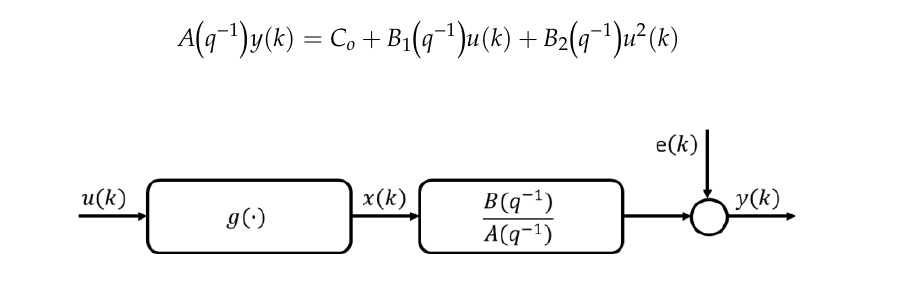
Figure 3. Block diagram representation of SISO Hammerstein model.